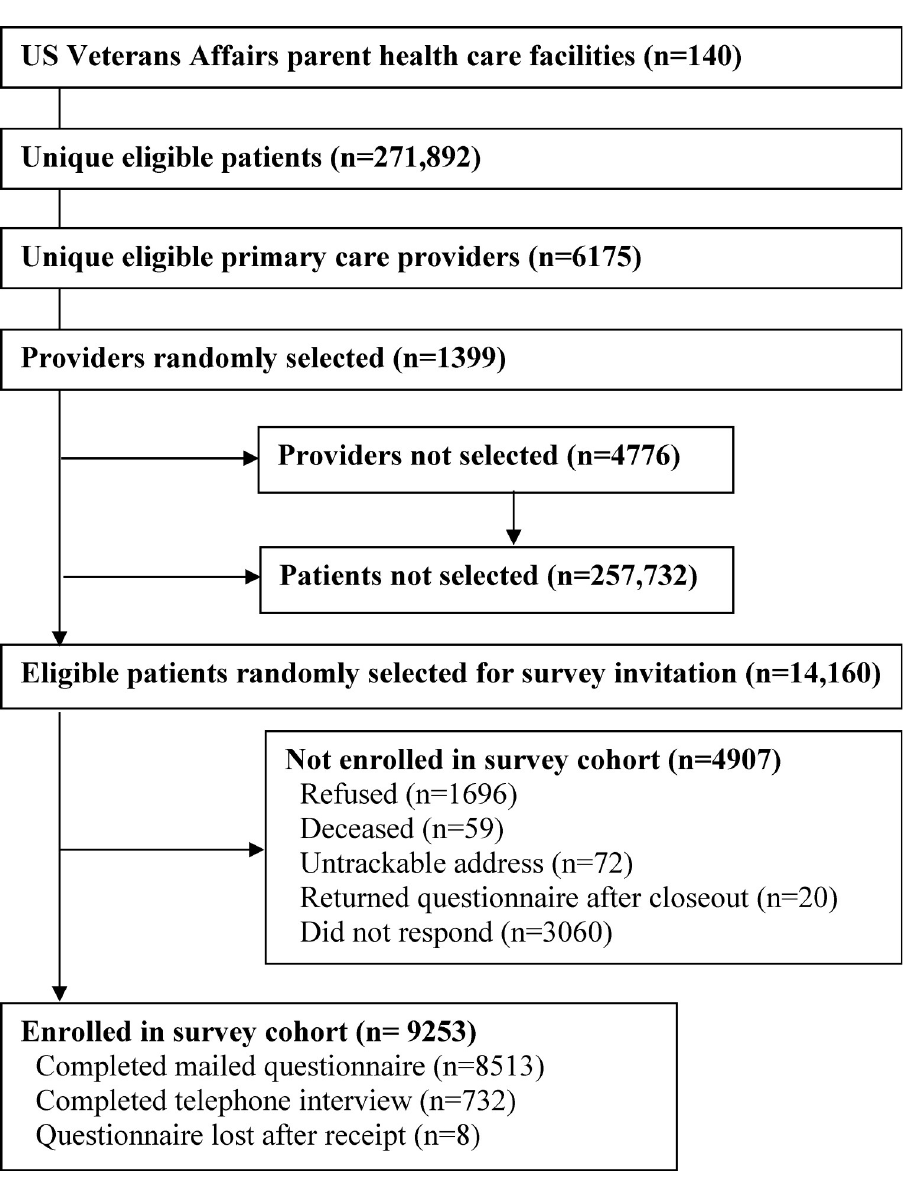
Fig 1. Study flow